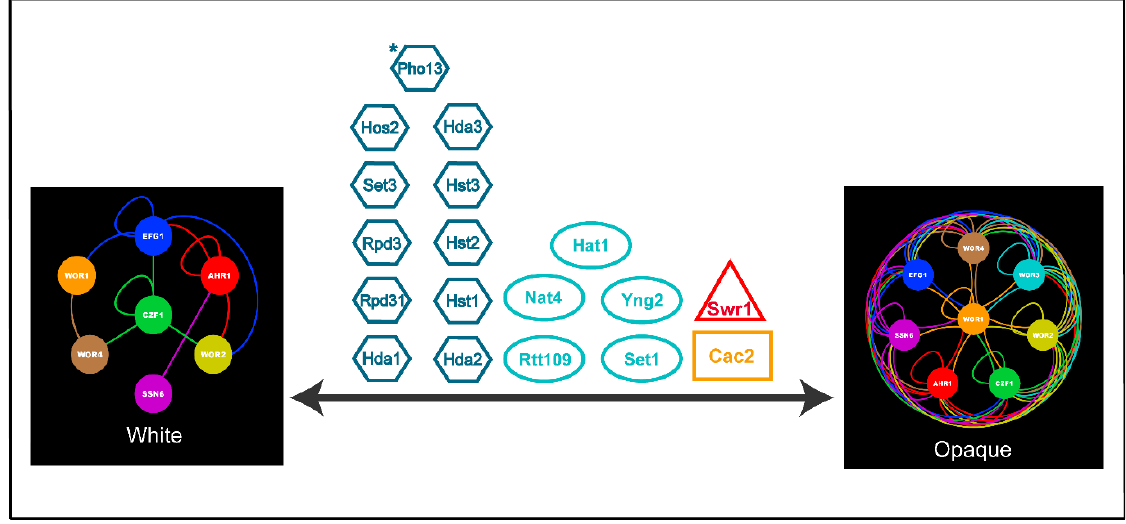
Figure 3. Summary illustration of the roles of chromatin regulating proteins in modulating the C. albicans white-opaque switch. Colored lines within the core white and opaque transcriptional circuits indicate direct binding interactions between each TF (same color as their circular node) and their respective target genes. Data to create the transcriptional circuits was obtained from [4,9,22,23,25,27]. Transcriptional circuits were generated using Cytoscape [31]. White to opaque and opaque to white switching is indicated by the central black arrows. Erasers are shown as blue hexagons, writers are shown as aqua ovals, chromatin remodelers are shown as red triangles, and histone chaperones are shown as orange rectangles. Note that Yng2 is a subunit of the NuA4 complex and that Cac2 is a subunit of the CAF-1 complex. *Pho13 has been shown to lack protein phosphatase activity and is instead involved in metabolism [159,160].